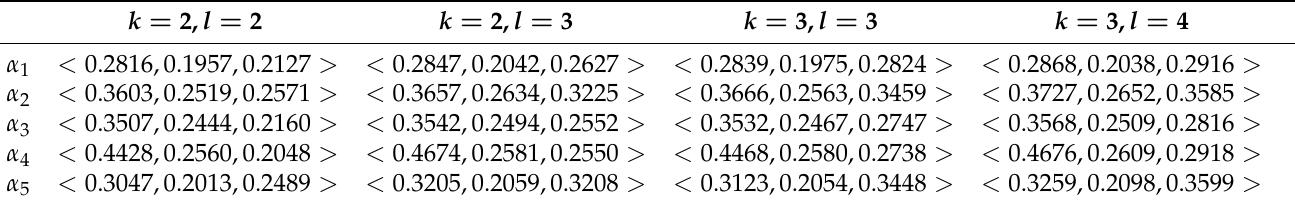
Table 3. Aggregated results of the TSFWIBM